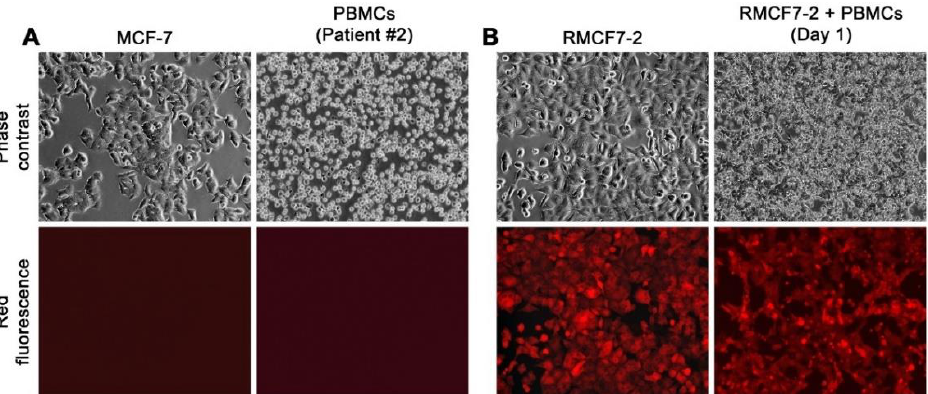
Figure 1. Using RFP tagging to facilitate cell tracking in co-culture. A representative co-culture is used to demonstrate the differences of MCF-7 from HCs. All the images are shown at 100 × magnification. ( A ) Marked differences in morphology and growth behavior between MCF-7 and PBMCs derived from the second breast cancer patient (Patient #2). ( B ) A co-culture setup on the first day (Day 1), with an RMCF7-2 cell monolayer overlaid by PBMCs of the Patient #2. RMCF7-2 cells in the co-culture could be tracked with red fluorescence microscopic imaging.